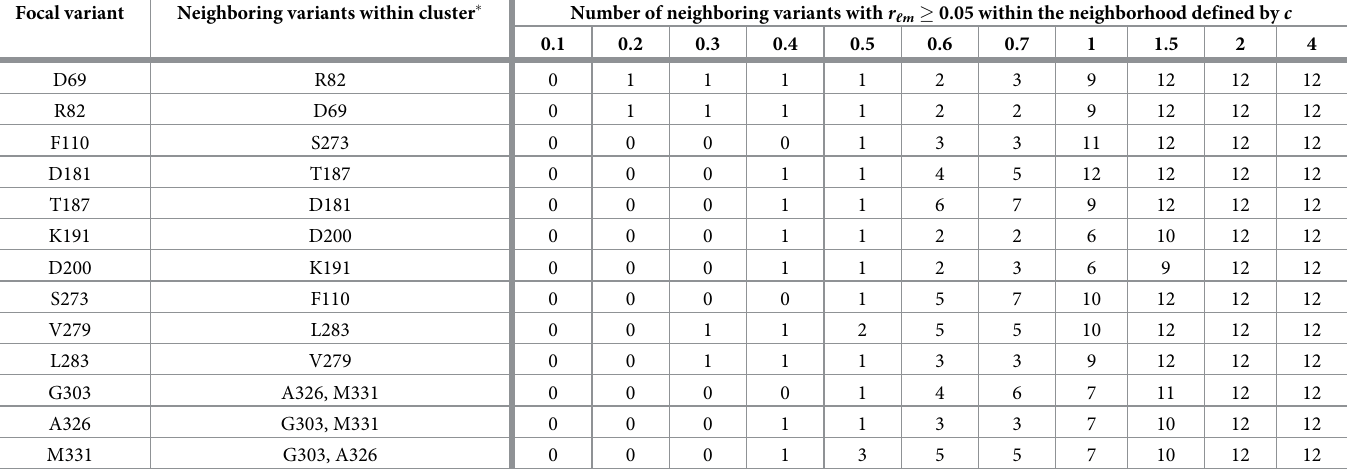
Table 1. Counts of neighboring variants which contribute “significantly” to the focal rare variants in PLA2G7 for different values of c. Neighboring variants ℓ ’s contributing � 5% of the information to the focal variant m (i.e., neighboring variants with r ℓm � 0.05) are considered as “significant”. Focal variant Neighboring variants within cluster